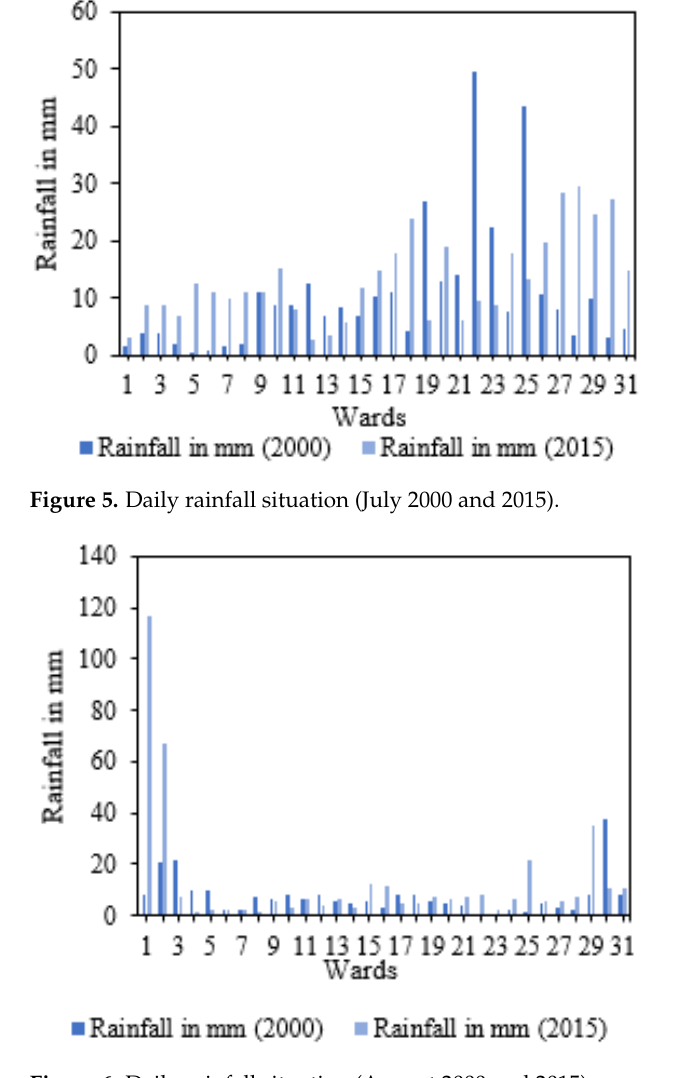
Figure 6. Daily rainfall situation (August 2000 and 2015).